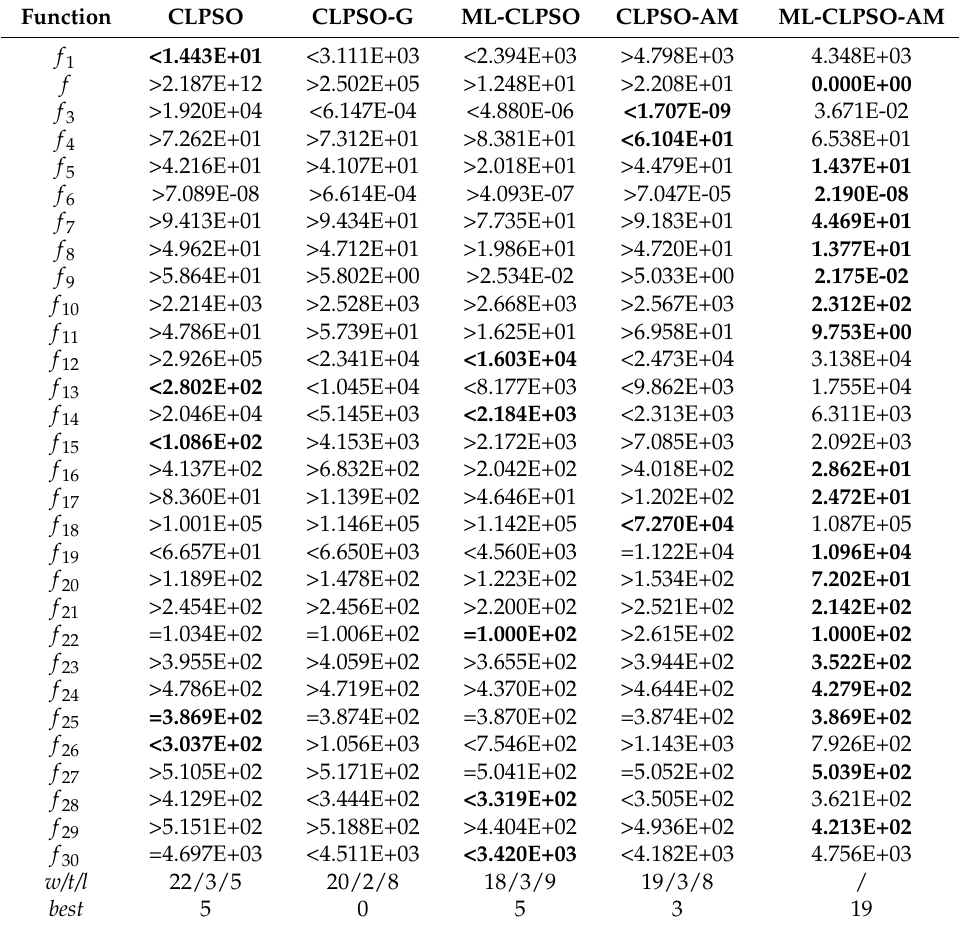
Table 2. Test results of CLPSO with different